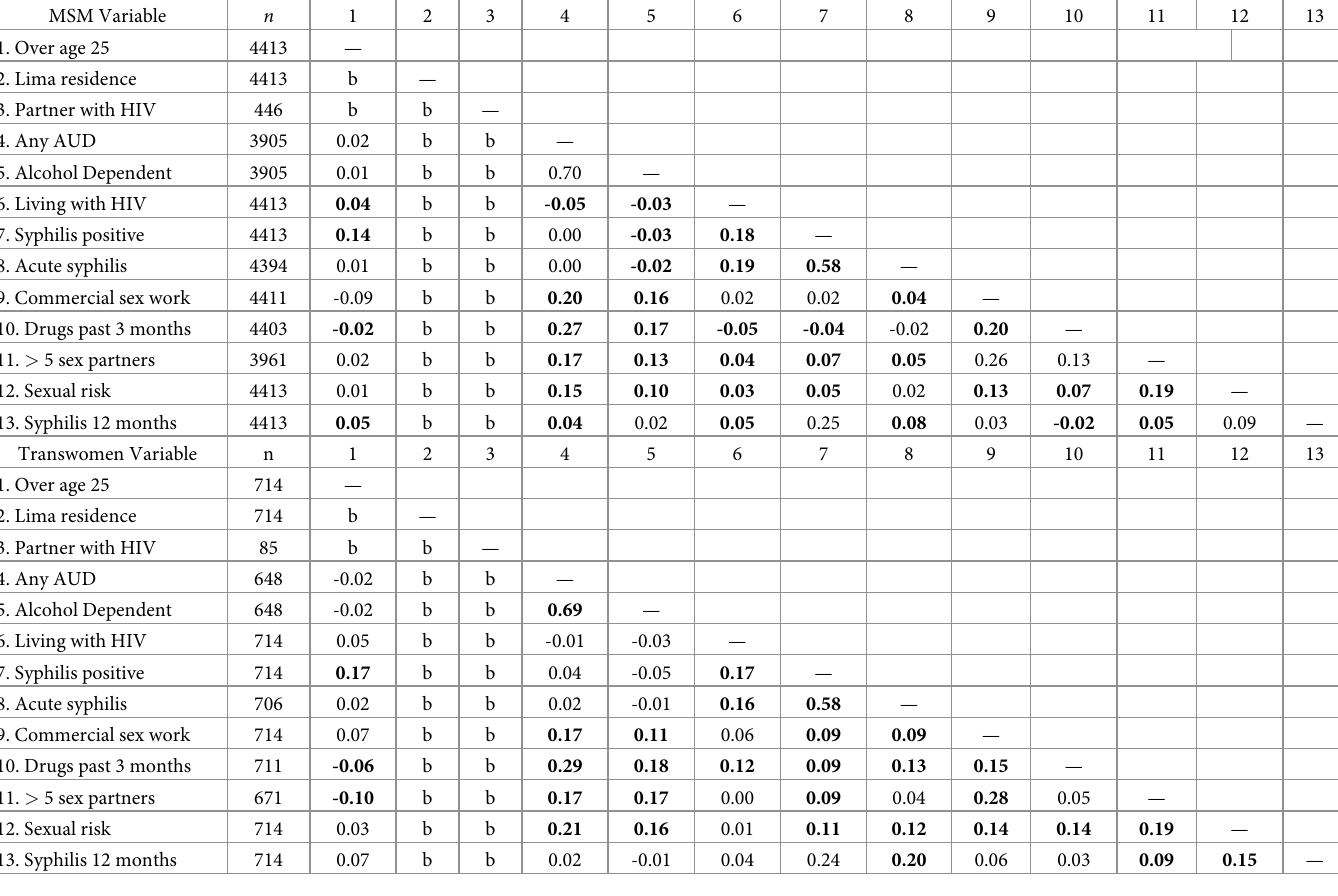
Table 3. Correlations between all HIV risk factor differences among transwomen and men who have sex with men (N = 5,127). MSM